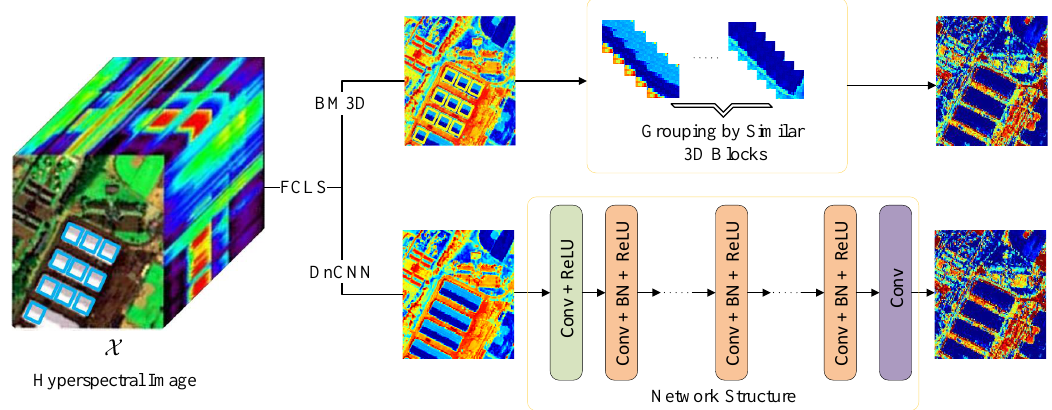
Figure 1. Denoising an abundance map in San Diego Airport image using BM3D and DnCNN denoisers.